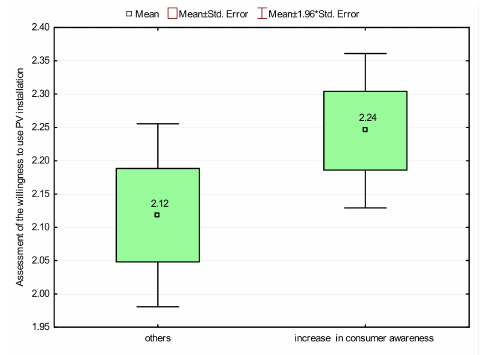
Figure 14. What effects can decarbonization policies have: increased consumer awareness (e.g., reducing energy consumption) vs. assessment of the willingness to use PV installations.